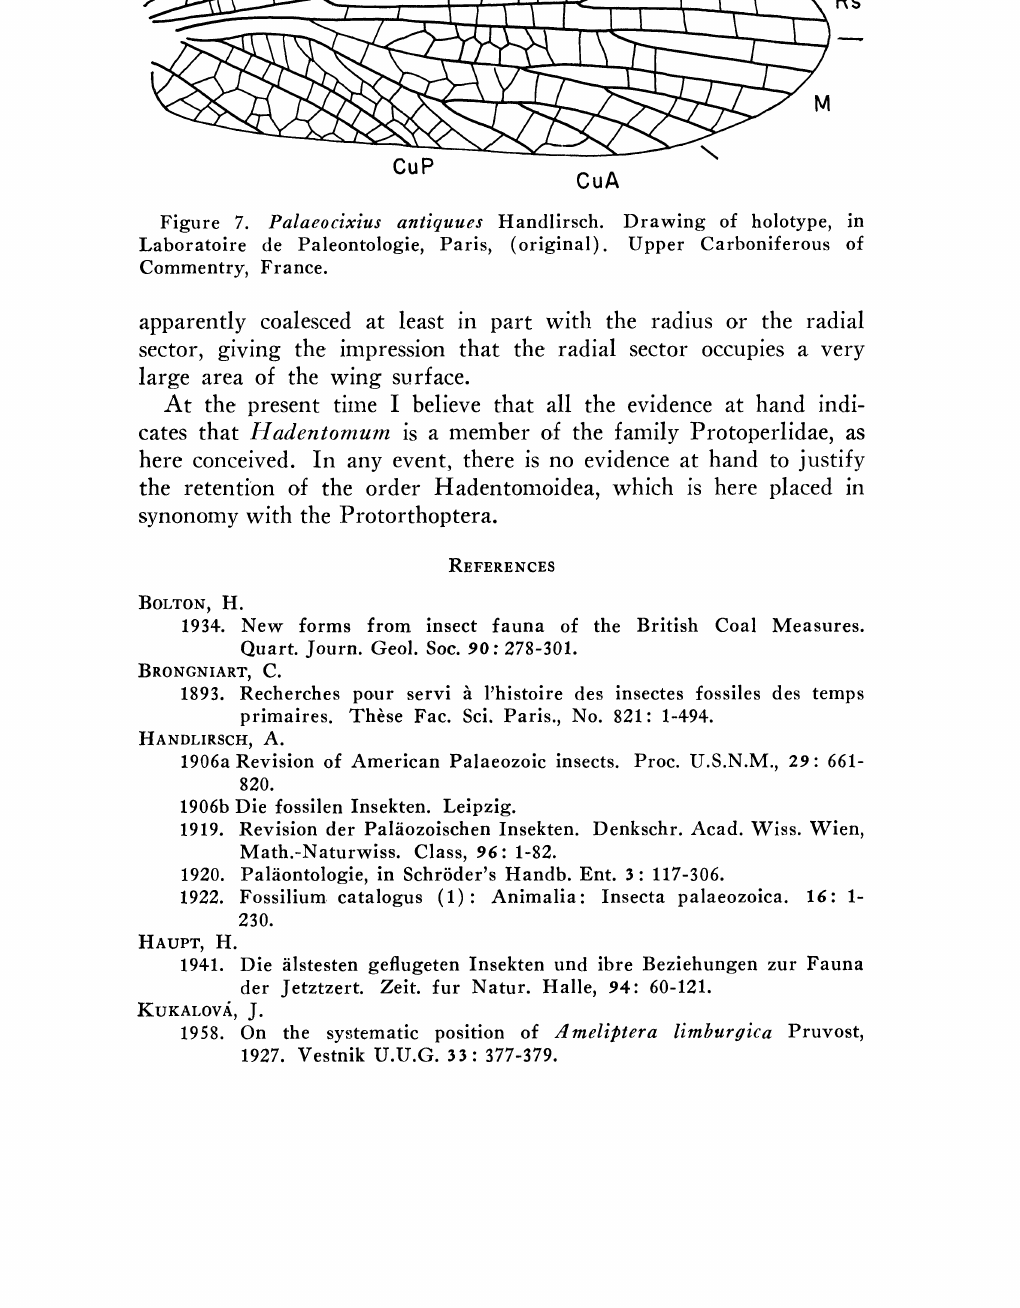
Figure 7. Palaeocixius antiquues Handlirsch. Drawing of holotype, in Laboratoire de Paleontologie, Paris, (original). Upper Carboniferous of Commentry,